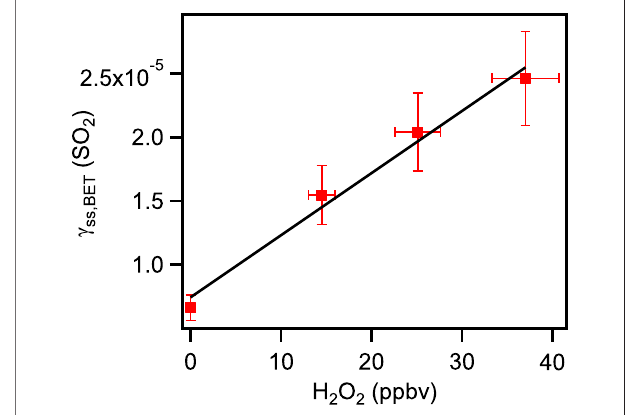
FIGURE 5 | Dependence of the steady state uptake coef fi cients of SO 2 on different mixing ratios of H 2 O 2 .